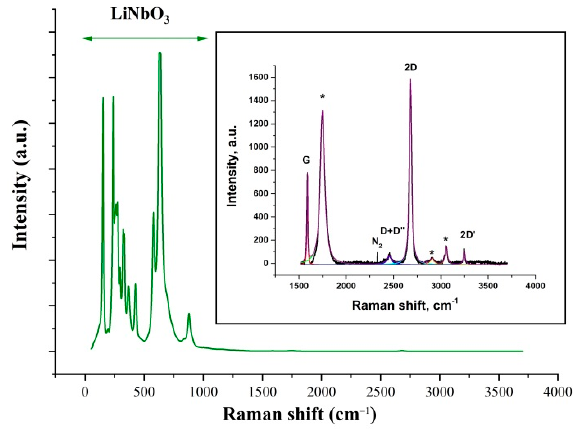
Figure 2. The representative Raman spectra of the graphene film transferred to the LiNbO 3 substrate. Insert: zoomed-in spectrum showing graphene Raman peaks.